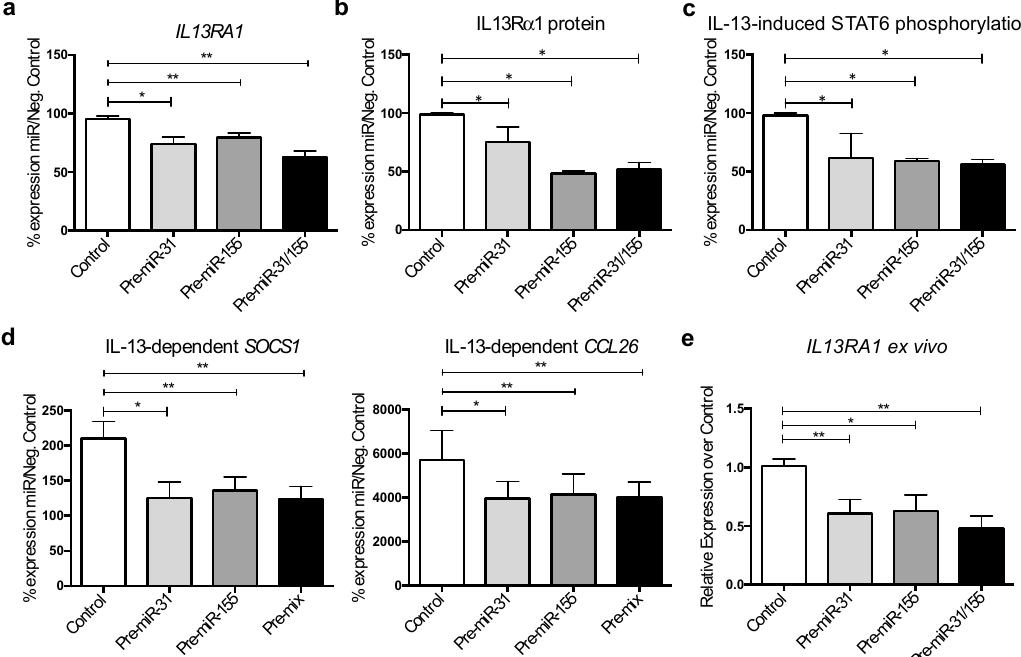
Figure 5. MiR-31 and miR-155 regulate the expression of IL13R α 1 in gut epithelium: ( a ) Bar graph representing the % of relative expression of IL13RA1 mRNA (left, n = 9); and ( b ) Protein (right, n = 3) after transfecting HT-29 cells with miR control, miR mimics for miR-31, miR-155 or a combination of both miR-31 and miR-155; ( c ) Bar graph depicting the densitometry results for IL-13-dependent phospho-signal transducer and activator of transcription 6 (STAT6) in HT-29 cells transfected with miR control, miR mimics for miR-31, miR-155 or a combination of both miR-31 and miR-155 ( n = 3); ( d ) Bar graph depicting the IL-13-dependent expression of suppressor of cytokine signaling 1 ( SOCS1) and eotaxin-3 ( CCL26) mRNA in HT-29 cells transfected with miR control, miR mimics for miR-31, miR-155 or a combination of both miR-31 and miR-155 ( n = 9); and ( e ) Bar graph depicting the mRNA expression of IL13RA1 in inflamed UC biopsies transfected with miR control, miR mimics for miR-31, miR-155 or a combination of both miR-31 and miR-155 ( n = 7), relative to negative control. Represented are mean + standard error of the mean. Statistics were done employing t -tests *: p -value ≤ 0.05; **: p -value ≤ 0.01.